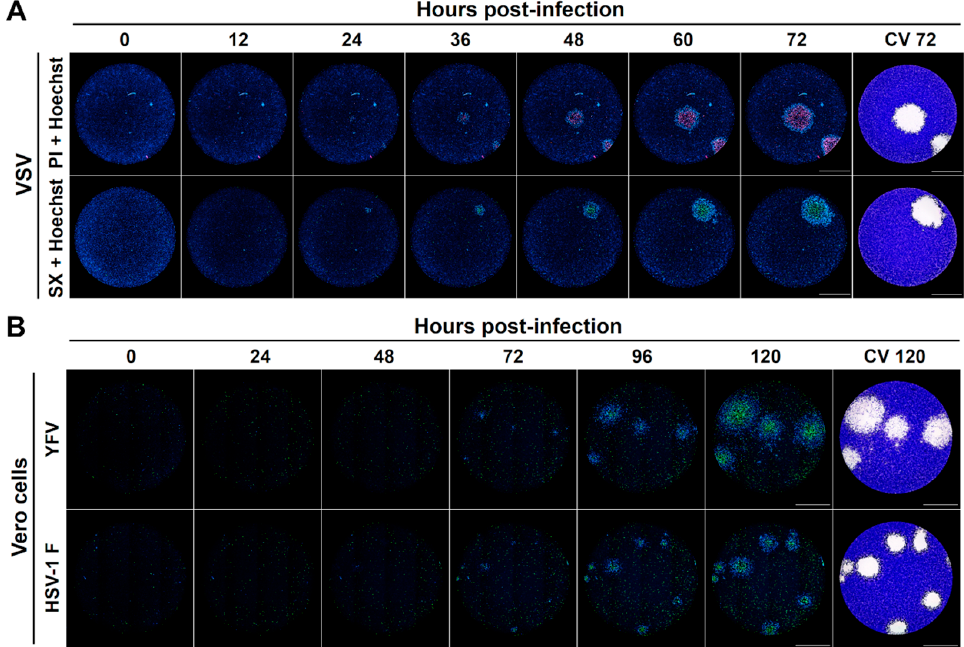
Figure 3. Labeling of individual viral plaques with DNA fluorescent dyes allows the development of a real-time plaque assay for the kinetic analysis of virus-induced cytopathic effect by live-cell imaging. ( A ) Vero cells were inoculated with infectious VSV seed, cell nuclei were stained with Hoechst, and cells were subjected to a kinetic plaque assay for 72 h with a medium containing one of the cell death dyes propidium iodide (PI) or SYTOX Green (SX). Live-cell imaging acquisition was performed every 12 h and after the final read viral plaques were confirmed by the standard crystal violet staining. ( B ) Vero cells were inoculated with either infectious YFV or HSV-1 F seeds, cell nuclei were Hoechst stained, and cells were subjected to a kinetic plaque assay for 120 h with a medium containing the cell death staining SYTOX Green. Live-cell imaging acquisition was performed every 24 h, and at the end of the experiment, viral plaques were confirmed by the standard crystal violet staining. A representative experiment is shown in each panel (n = three independent experiments), total magnification of 40X, scale bar = 2000 µm.